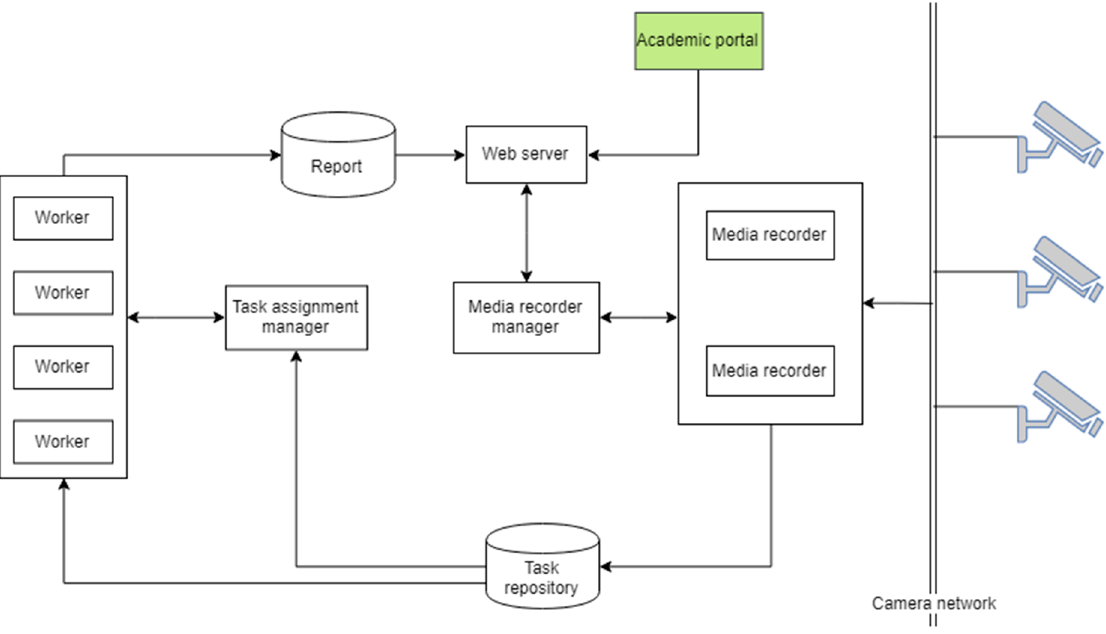
Figure 1. This figure shows an overview of the system that contains seven components: recorder, recorder controller, task repository, task assignment manager, worker, and report and web server.